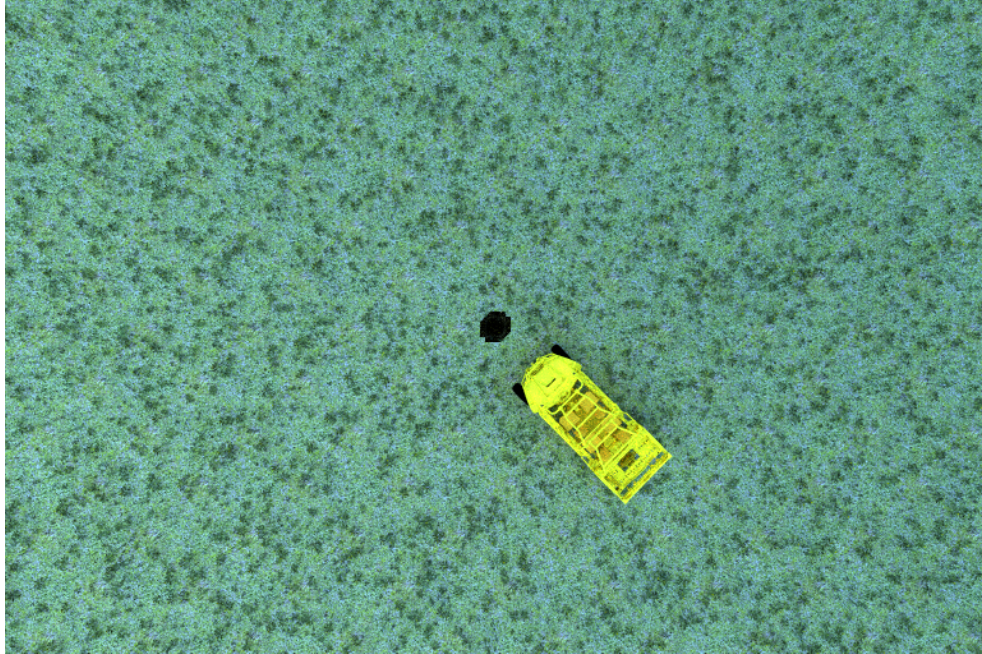
Figure 5. Rendering of the simulated scenario. The UGV moves toward the negative obstacle, a hole which is large enough to damage or immobilize the